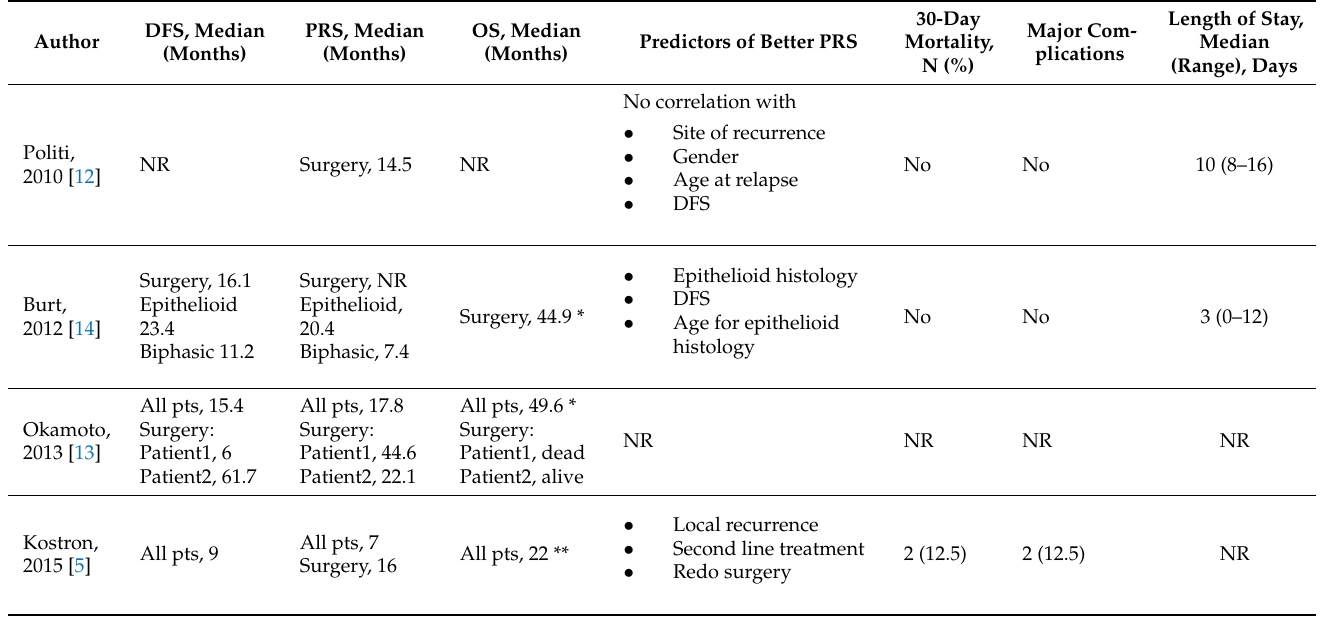
Table 2. Short- and long-term outcomes of recurrent MPM patients who underwent second